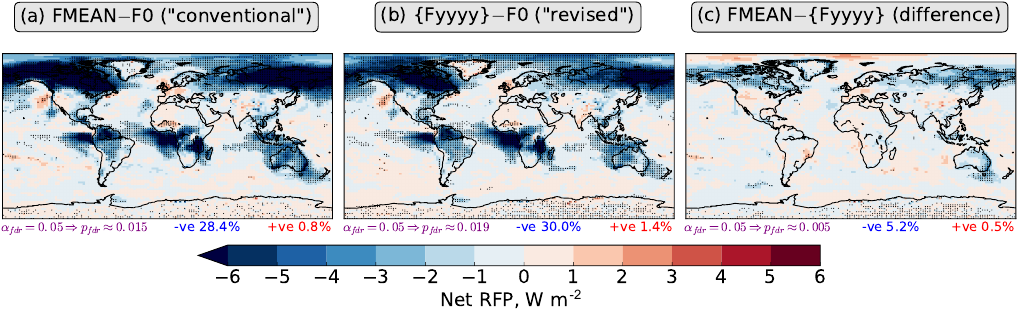
Figure 6. Net (shortwave plus longwave) top-of-atmosphere radiative flux perturbations (RFPs) for (a) simulation FMEAN relative to simulation F0, (b) the { Fyyyy } ensemble relative to simulation F0, and (c) the FMEAN −{ Fyyyy } difference. Stippling indicates differences that are statistically significant at a significance level of α fdr = 0 . 05 after controlling the false discovery rate (FDR; Benjamini and Hochberg, 1995; Wilks, 2016). The two-tailed p values are generated by Welch’s t test, using annual mean data as the input. The approximate p value threshold, p fdr , is written in purple underneath each map. The percentage of the globe (area-weighted) over which negative ( − ve) statistically significant differences occur is written in blue text underneath each map, while the percentage of the globe over which positive ( + ve) statistically significant differences occur is written in red